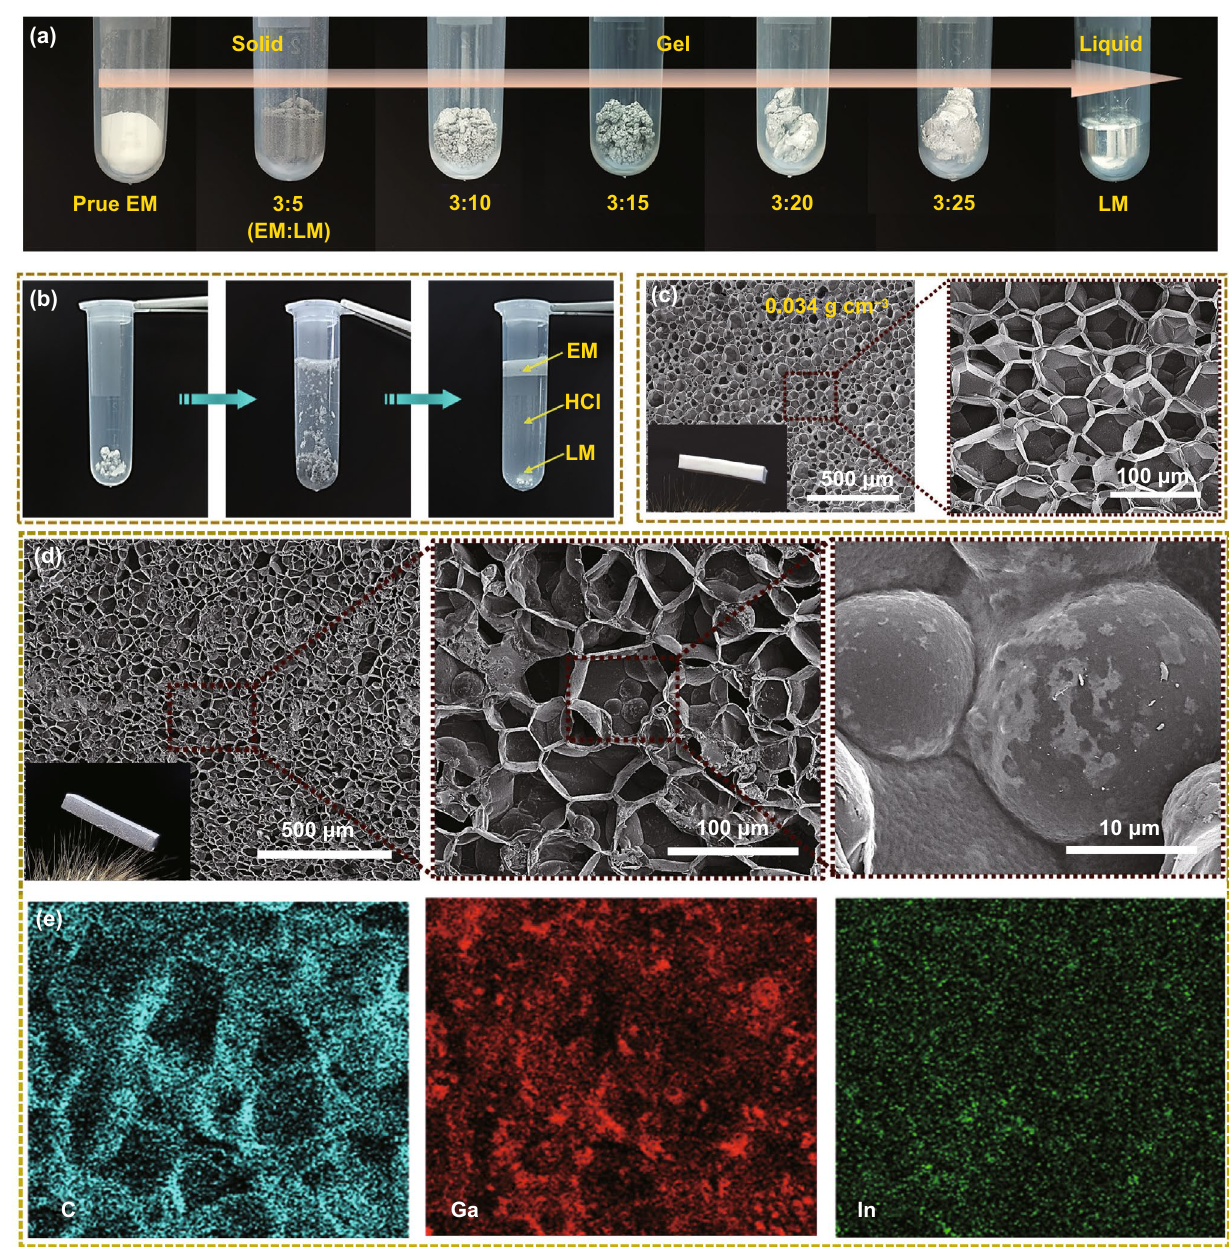
Fig. 2 Structural characterization of EM/LM compounds, EMm and EM/LMm. a Optical photographs of EM/LM compounds at various ratios, beginning as EM and transitioning from a solid‑like to a liquid‑like material as more LM added. b Demonstration of recyclability of EM/LM compounds, automatic separation of two components depends on the density difference in dilute HCl solution. c Cross‑sectional SEM images of EMm at the density of 0.034 g cm −3 . d Cross‑sectional SEM images of EM/LMm at the density of 0.126 g cm −3 . e EDS mapping of cross‑ sectional EM/LMm and its uniform distribution of Ga and In